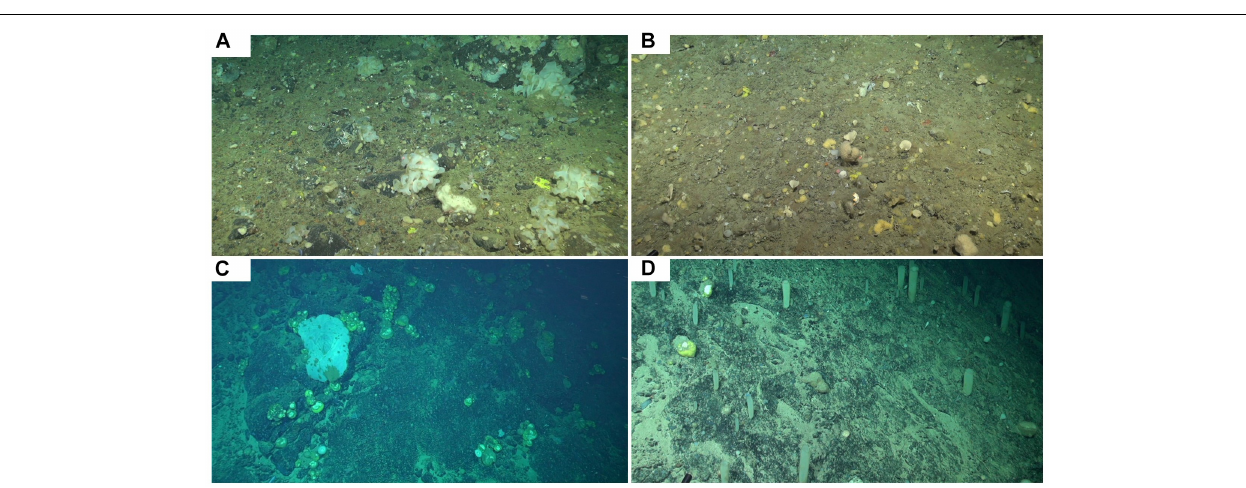
software was used to align the images and create a 3D surface mesh using structure-form-motion algorithms (Westoby et al., 2012); the SGM algorithm (Hirschmüller, 2005) and scale invariant feature transform (SIFT) operator (Lowe,